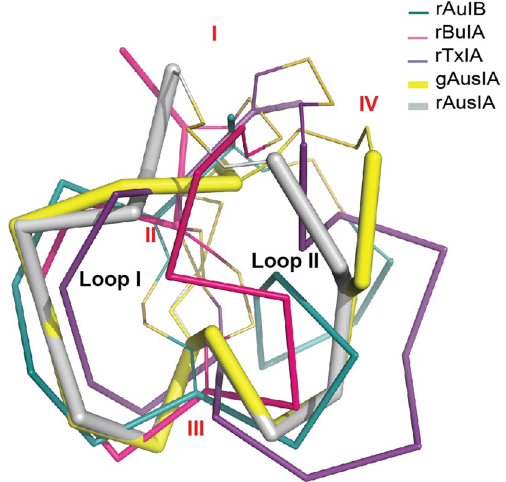
Figure 5. The superimposition of gAusIA and rAusIA with ribbon isomers of α4/4-BuIA (PDB 2NS3), α4/6- AuIB (PDB 1MXP) and α4/7-TxIA (PDB 6OTA).